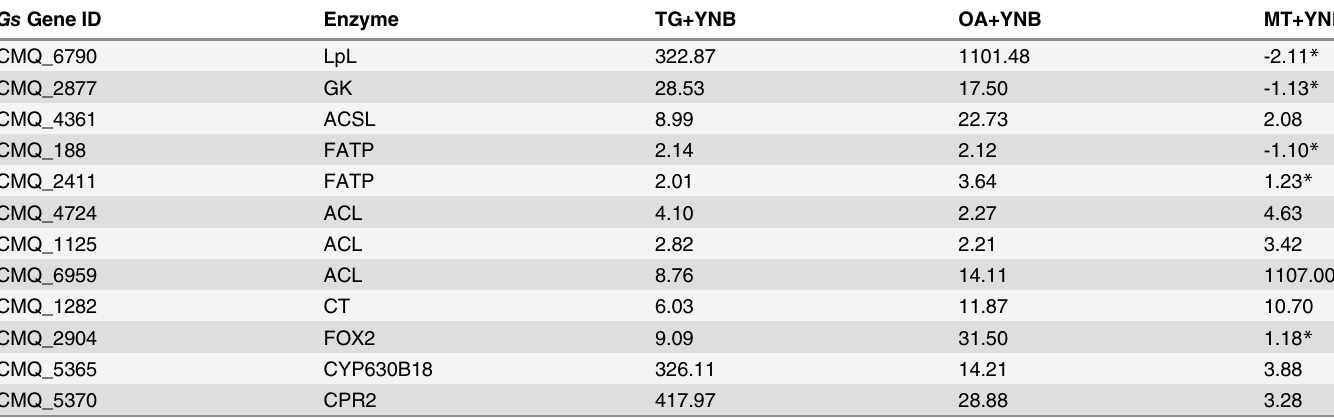
Table 3. Changes in transcript abundance of genes involved in the Gs CYP630B18 putative fatty acid oxidation pathway following growth on monoterpenes, triglycerides or oleic acid as the sole carbon